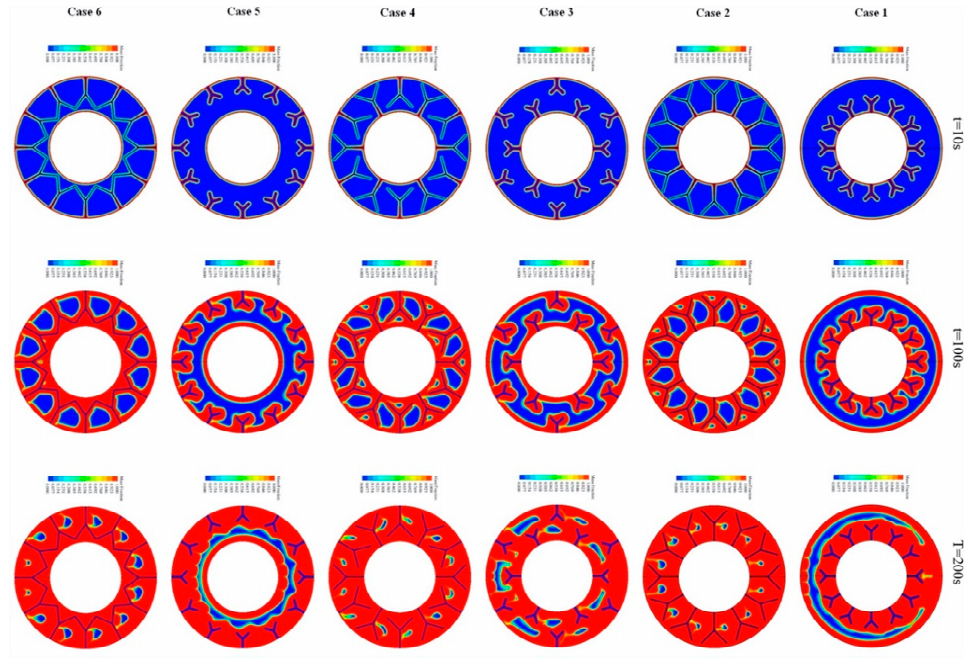
Figure 11. The liquid fraction in the six different cases at different times. (Copyright 2020 Elsevier) [80].